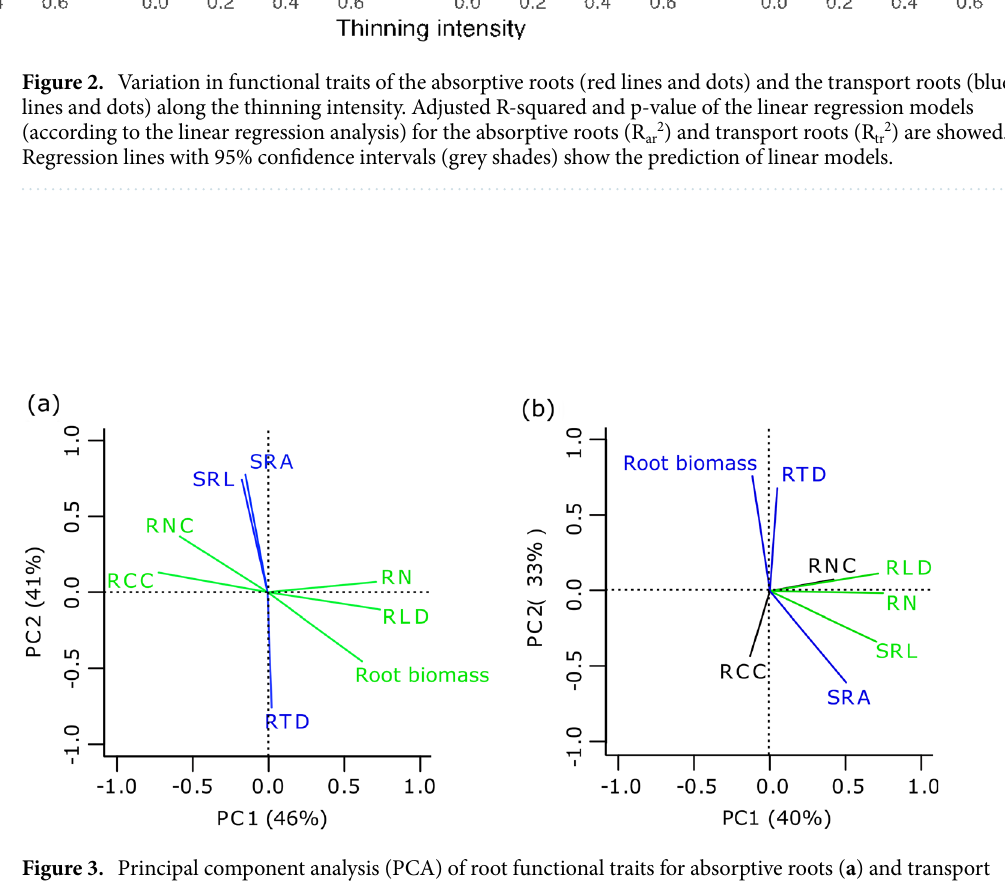
Figure 3. Principal component analysis (PCA) of root functional traits for absorptive roots ( a ) and transport roots ( b ). Traits with green and blue colors were positively related to the first principal component and the second principal component,